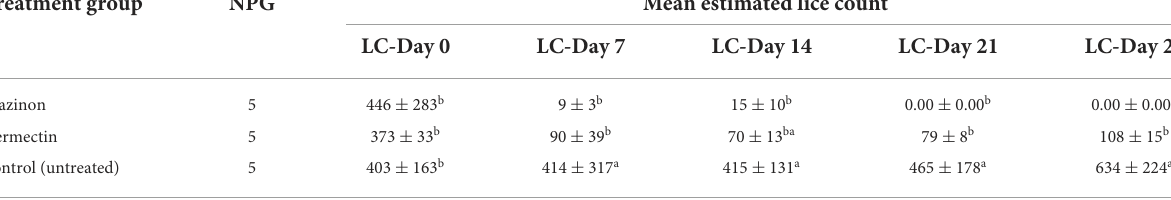
TABLE 7 Comparative effect of diazinon and ivermectin treatment on lice infestation in sheep in Sayint district, South Wollo, Ethiopia. Treatment